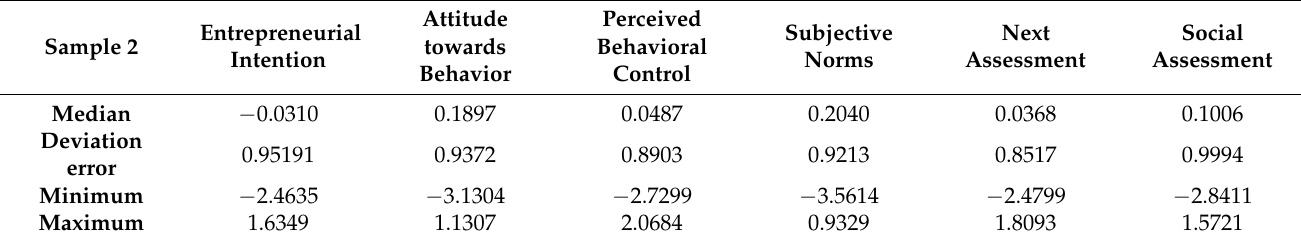
Table 4. Descriptive statistics of the scores obtained in sample 2.